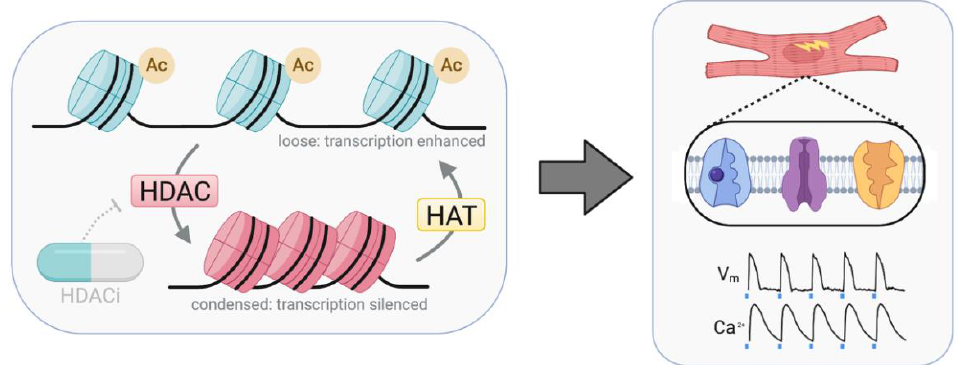
Figure 2. HATs and HDACs epigenetically regulate gene expression through reversible (de)acetylation of histone proteins. Activity of HAT and HDAC enzymes controls chromatin conformation, loosening (HAT) or condensing (HDAC) chromatin structure. Small-molecule HDACi pharmaceuticals disrupt this system and promote transcriptional enhancement. Effects on key cardiac ion channels are observable through functional electrophysiological experiments, e.g., contractility assays or measurements of transmembrane potential (V m ) and calcium (Ca 2+ ) transients. Representative V m and Ca 2+ transients modified from [15]. Created with Biorender.com. Table 1. HDACs and their associated roles in cardiac physiology. Chr indicates chromosome loca- tion. Heart exp indicates gene expression in the heart. TF indicates transcription factors. KO indicates knockout.